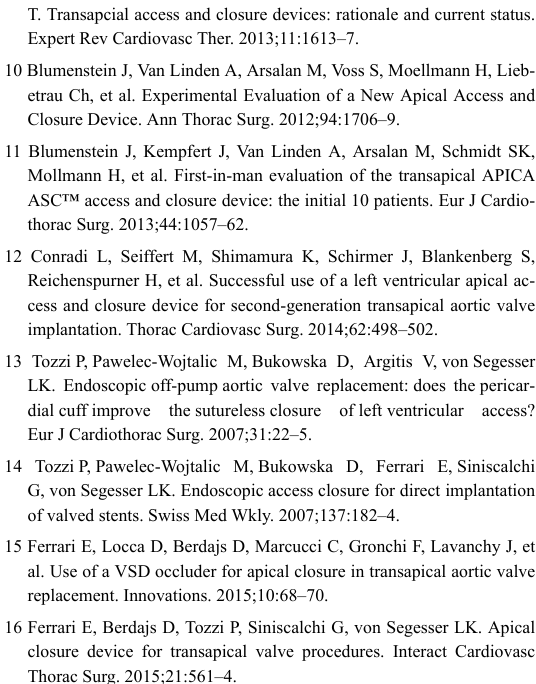
outcomes of transcatheter aortic valve replacement compared with standard treatment for patients with inoperable aortic